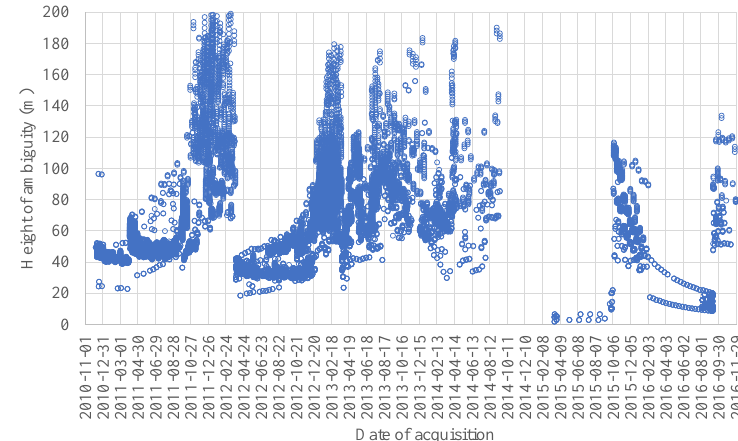
Figure 1. Height of ambiguity values for TanDEM-X acquisitions over the Amazon rainforest from the beginning of the operational mission at the end of 2010 to the end of